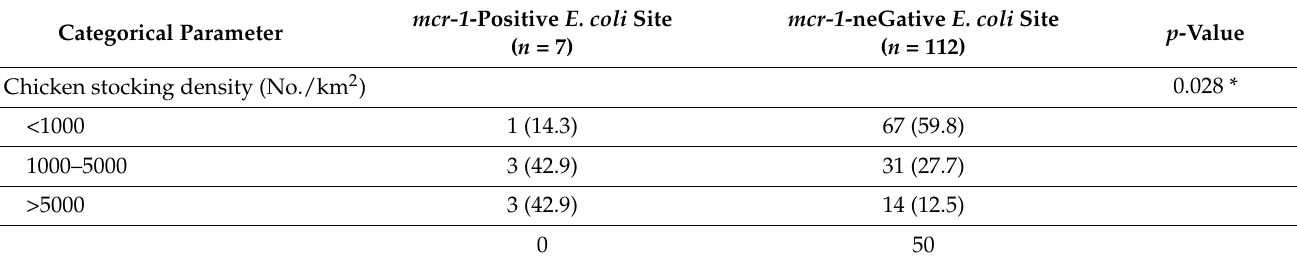
Figure 2. Livestock density and mcr -1 positive and negative site correlations: ( A ) (left): chicken density; ( B ) (right) pig density. According to the Chi-square test using categorical variables for analysis (Table 3), mcr - Table 3. Chi-square test of the mcr-1 -positive and mcr-1 -negative E. coli